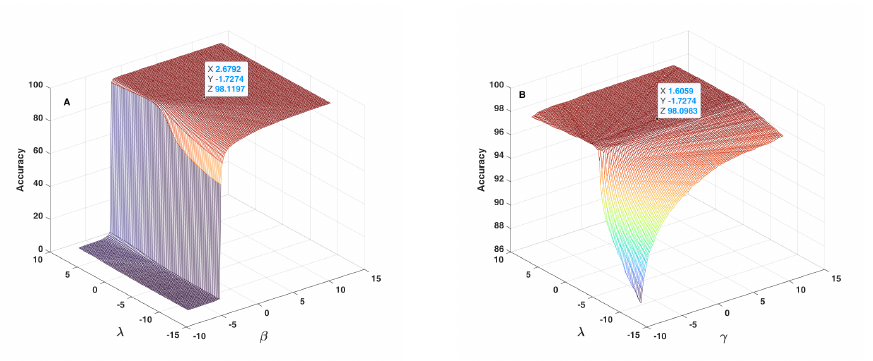
Figure 13. Accuracy in terms of α and λ parameters ( A ) and of β and γ parameters ( B ) used in the fusion step (Equation (14)).